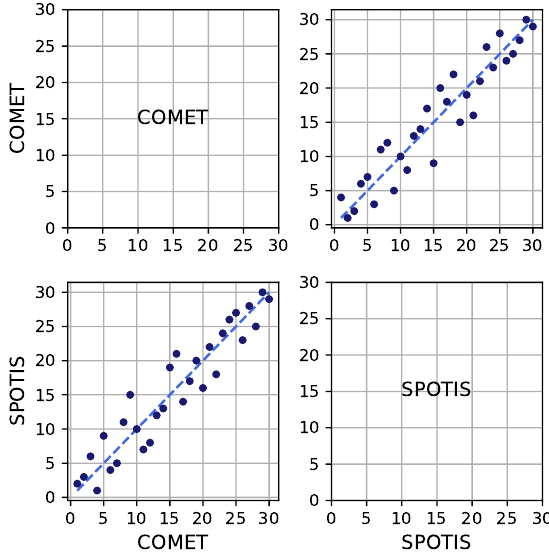
Figure 1. Comparison of rankings similarity obtained with COMET and